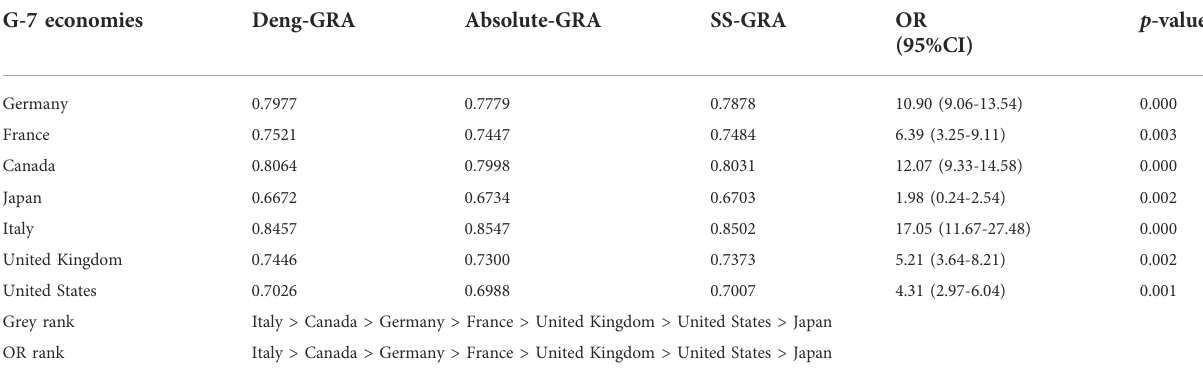
TABLE 2 Mathematical and statistical assessment between CO 2 emissions and renewable energy.